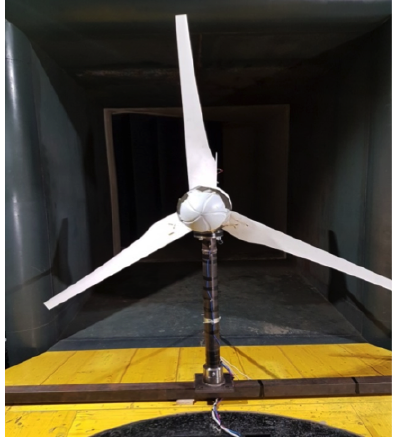
Figure 1. The front view of the wind turbine in the wind tunnel with the recovery test section (2.7 m × 2.7 m) on the background.